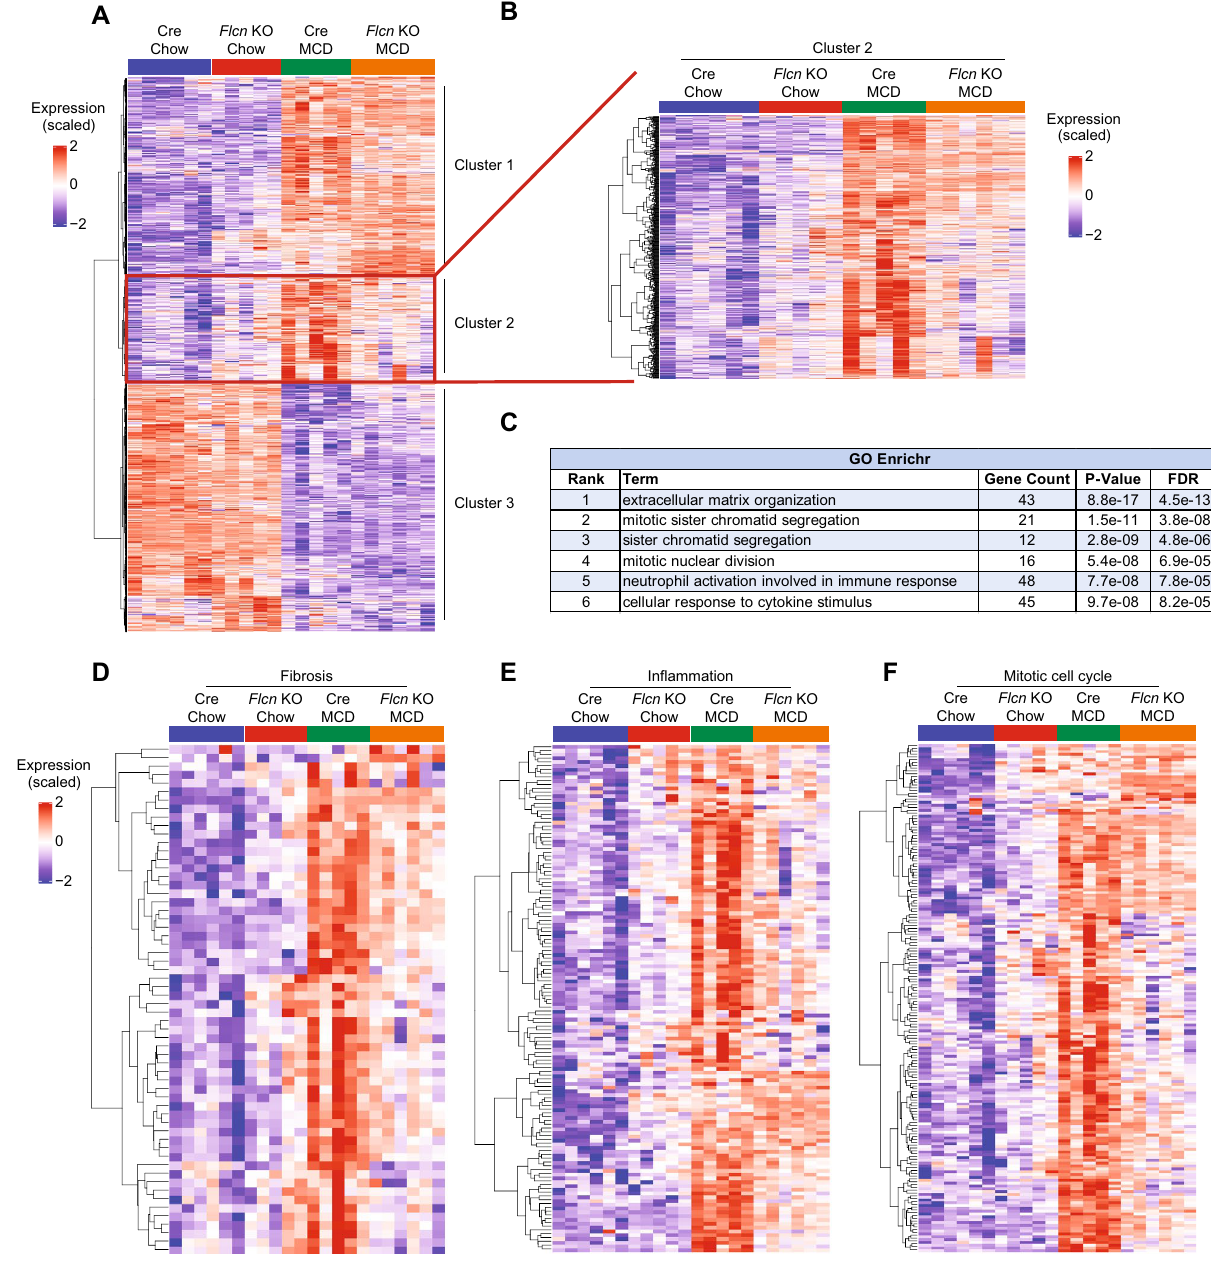
Figure 4. RNA-seq reveals major pathways affected by Flcn loss. ( A,B ) Unsupervised hierarchical clustering following RNA-seq analysis in livers of mice fed either chow or methionine/choline deficient diet (MCD) over a period of 6 weeks. ( C ) Gene enrichment analysis using GO Enrichr. ( D ) Unsupervised hierarchical clustering following RNA-seq analysis of fibrosis-related genes (GO:0030198). ( E ) Unsupervised hierarchical clustering following RNA-seq analysis of inflammation-related genes (GO:0006954). ( F ) Unsupervised hierarchical clustering following RNA-seq analysis of mitotic cell cycle-related genes